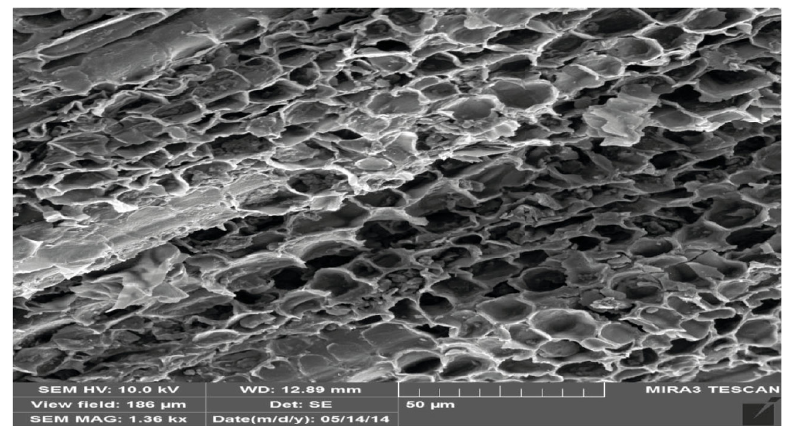
Figure 9: Scanning electron micrographs of DPWF before grafting, SEM MAG (1.36 KX).